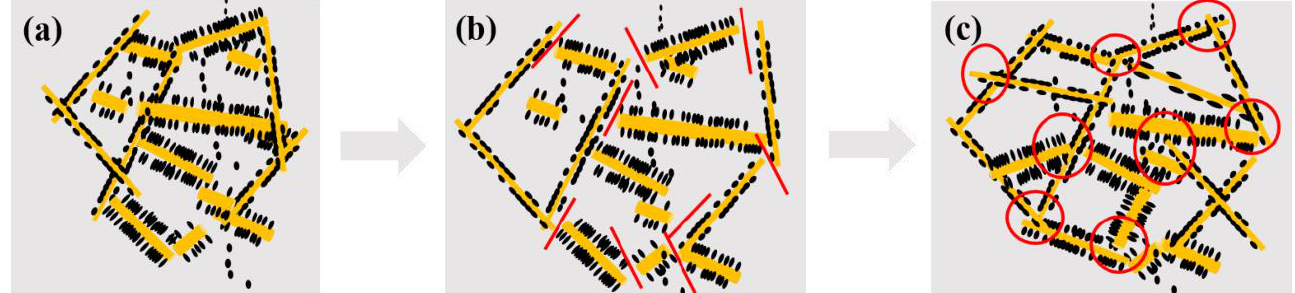
Figure 9. Schematic illustration of the conductive network evolution of CB/PA6/PP MFCs: ( a ) initial conductive network; ( b ) the conductive network under tension-strain; and ( c ) final conductive network. The lines and circles demonstrate the destruction and rebuilding of the conductive paths, respectively.